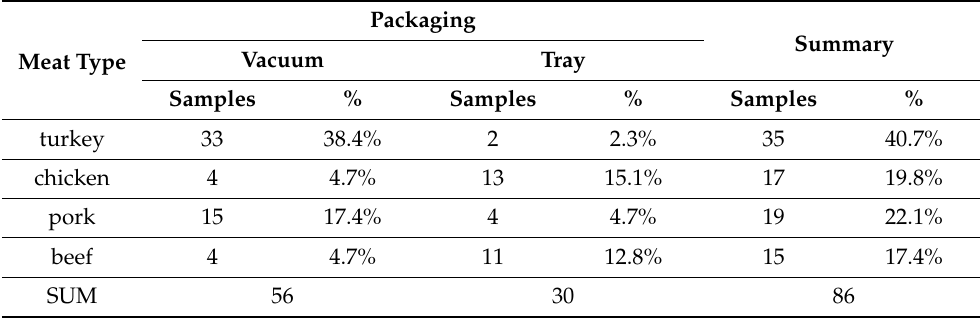
Table 1. Overview of the meat samples obtained from 5 markets in Gdansk, Poland, during 2020.